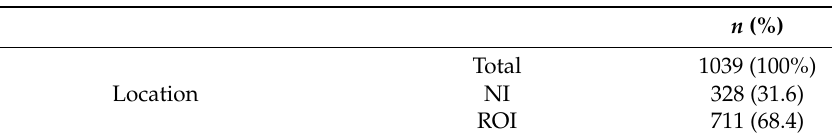
Table 1. Characteristics of